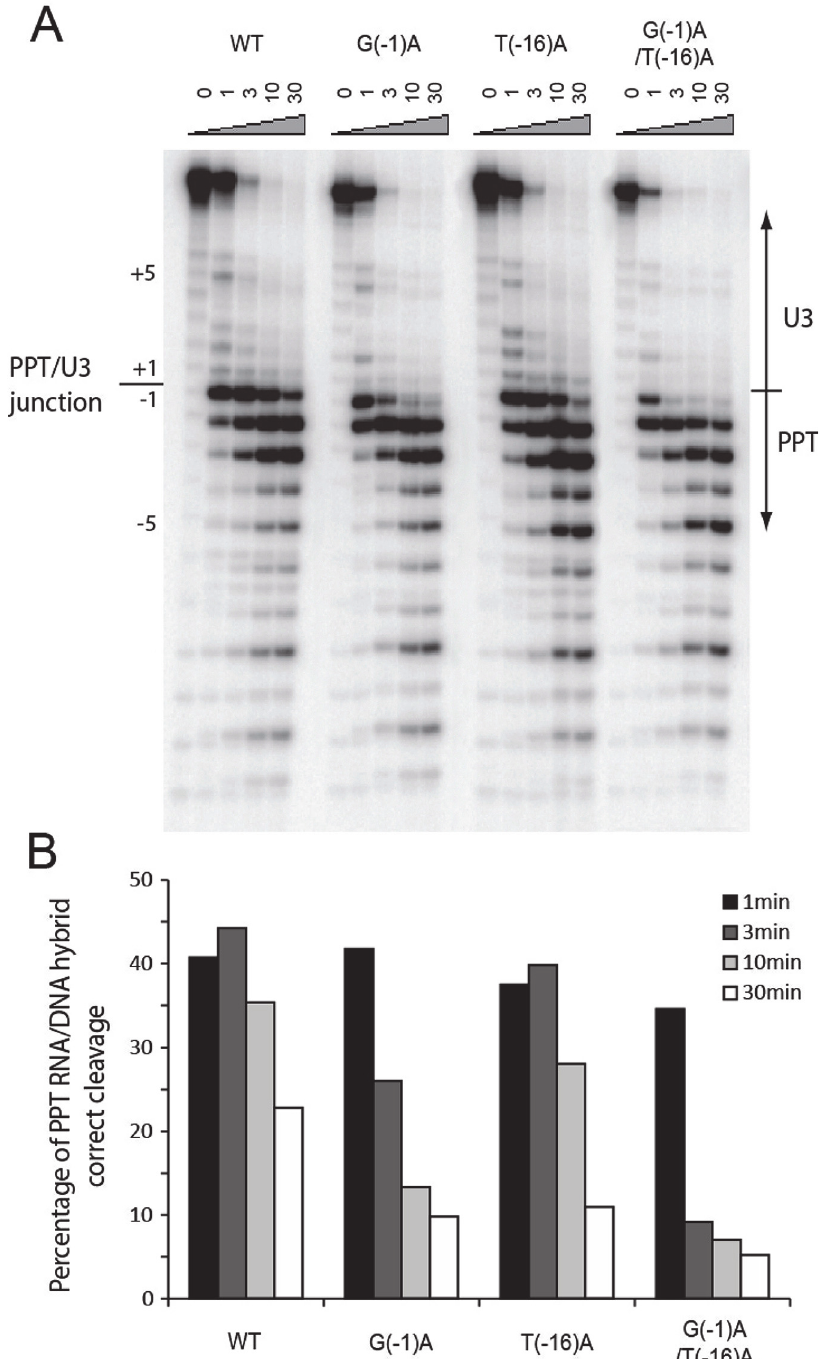
Fig 6. In vitro PPT RNA/DNA hybrids cleavage assay. (A) PPT RNA-DNA hybrid substrates (wild type, G (-1)A, T(-16)A, and G(-1)A/T(-16)A double mutants) were subjected to RNase H-mediated cleavage by HIV-1 RT in the absence of nucleotides. Reactions were terminated at 0, 1, 3, 10, or 30 min; (B) Quantitative analysis of PPT RNA-DNA hybrid cleavage.